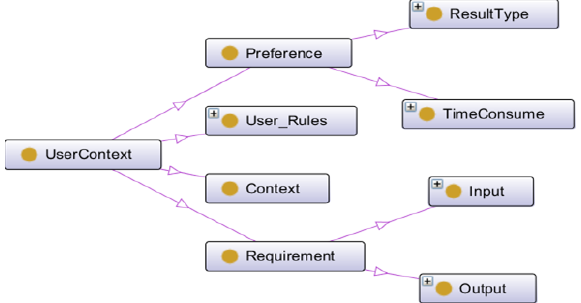
Fig.2. OWL-UC based user context